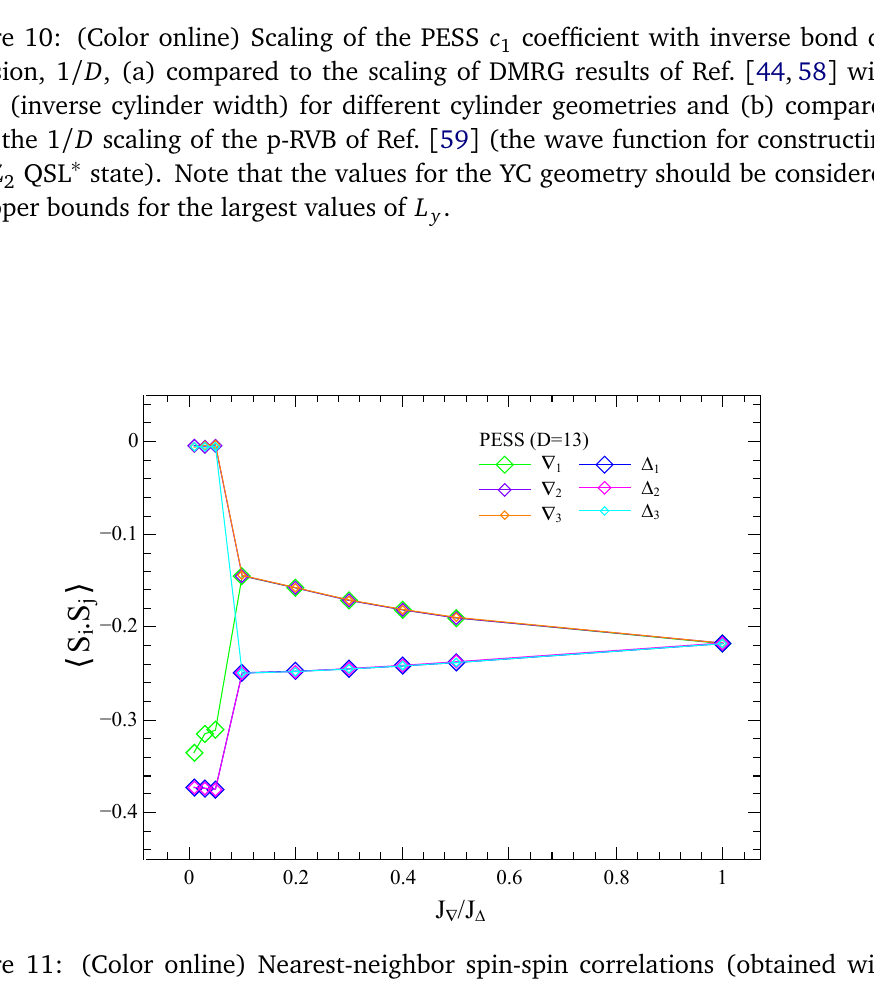
, (cid:52) , (cid:52) and on the 1 2 3